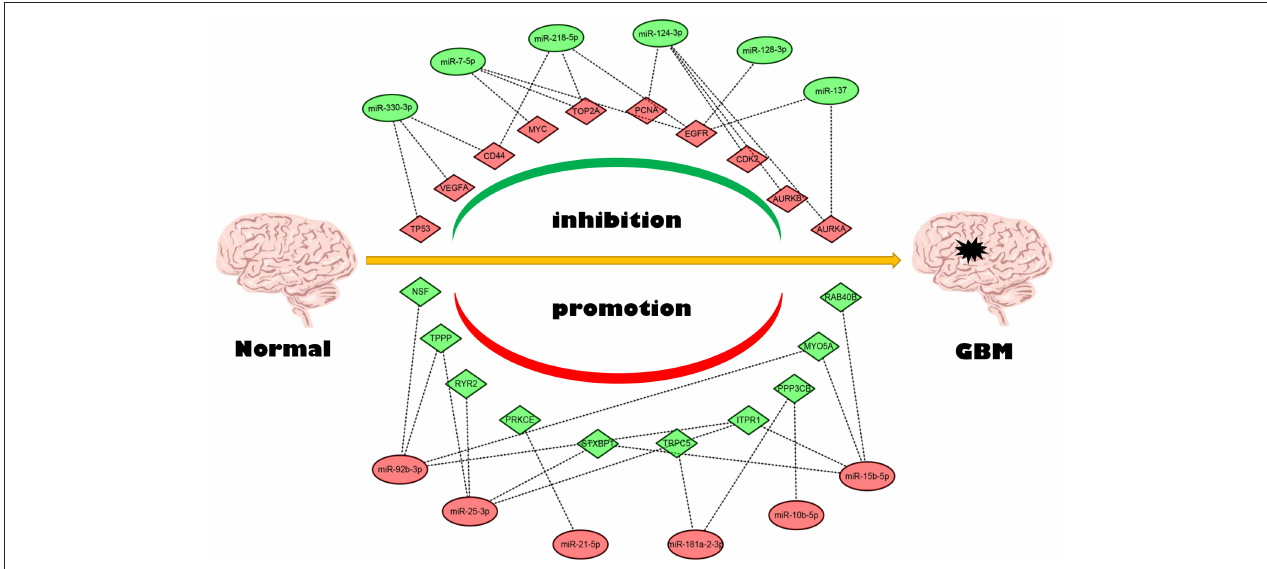
FIGURE 8 | The candidate miRNA-hub gene regulatory network in